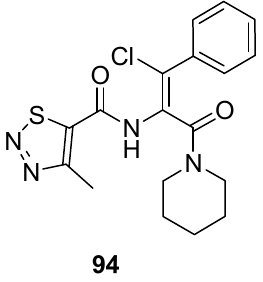
Figure 6. Antiviral activity of 1,2,3-thiadiazole 94 .